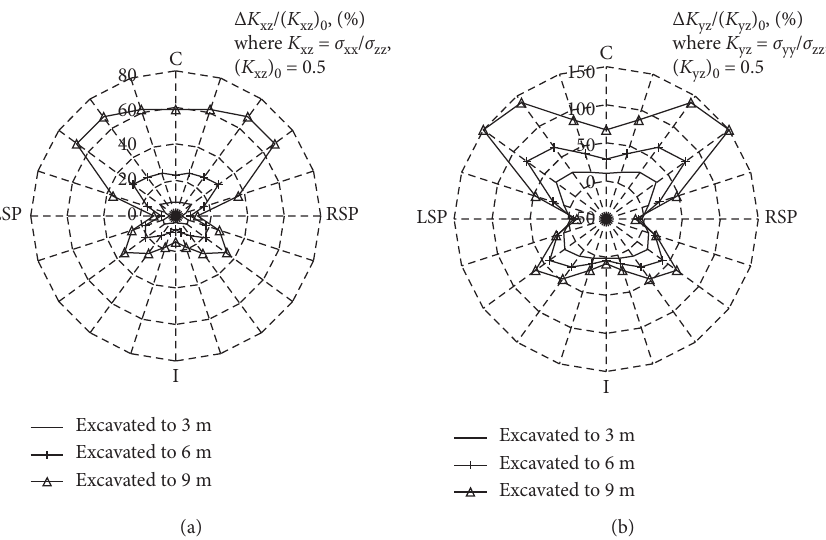
Figure 10: Changes in lateral Earth pressure coefficients (a) K xz and (b) K yz for various soil elements around the tunnel at the excavation center section for case C (initial K xz � K yz � 0.5). Monitor elements: C crown; LSP, left spring line; and RSP, right spring line.